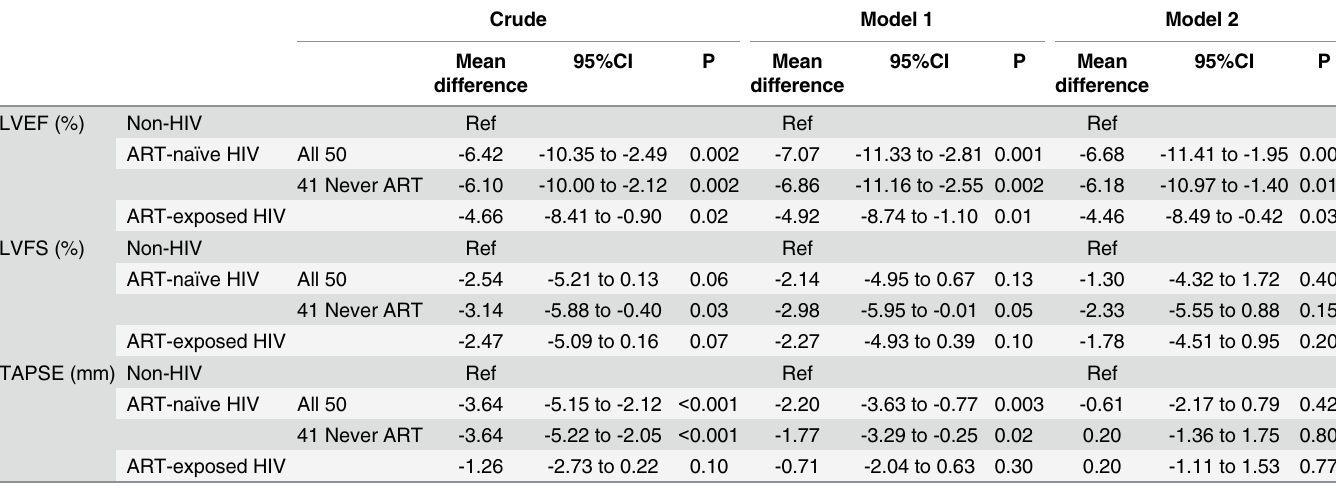
Table 3. Effects of HIV infection on cardiac functions.